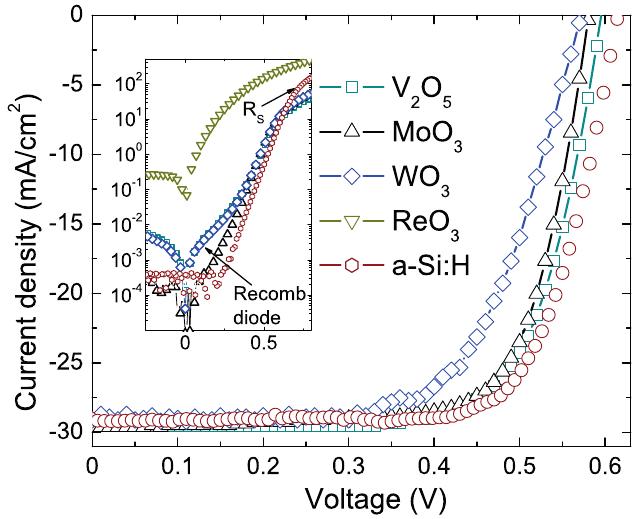
Figure 5. Current density-voltage ( J-V ) response of the fabricated oxide/n-Si solar cells under standard AM1.5g illumination, including an a-Si:H reference device. Inset shows J-V under dark